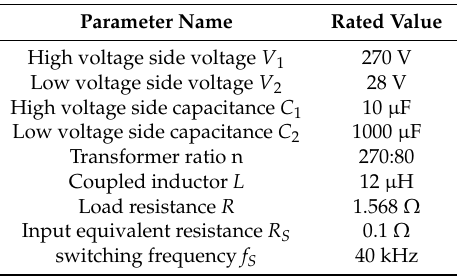
Table 1. Circuit parameters in the rated state converter.